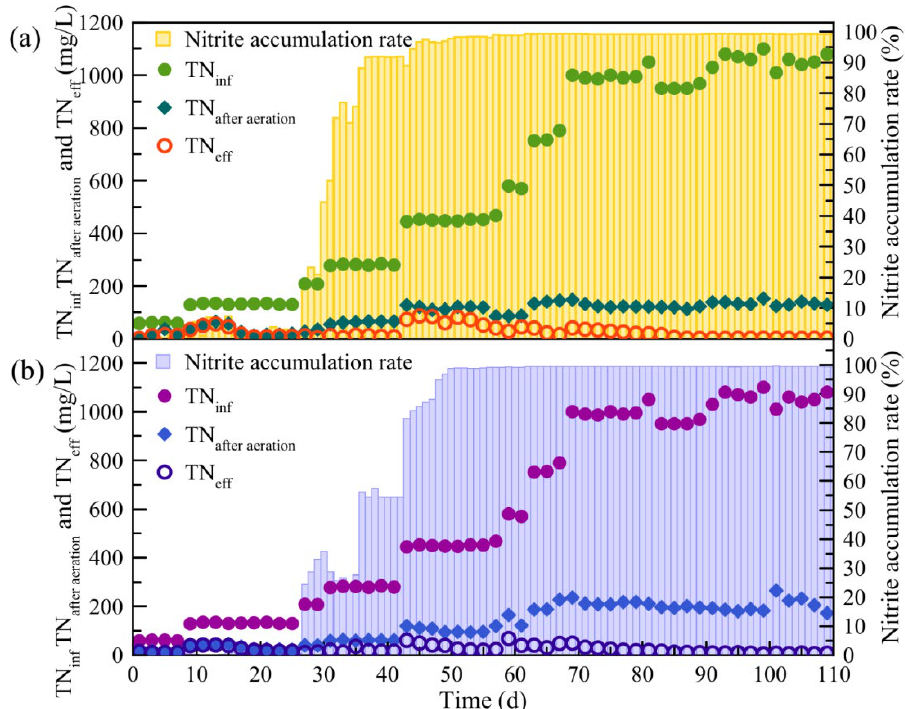
Figure 3. Removal of TN from landfill leachate by ( a ) SBBR; ( b ) SBR. (TN inf : total nitrogen concentration of influent; TN eff : total nitrogen concentration of effluent.).